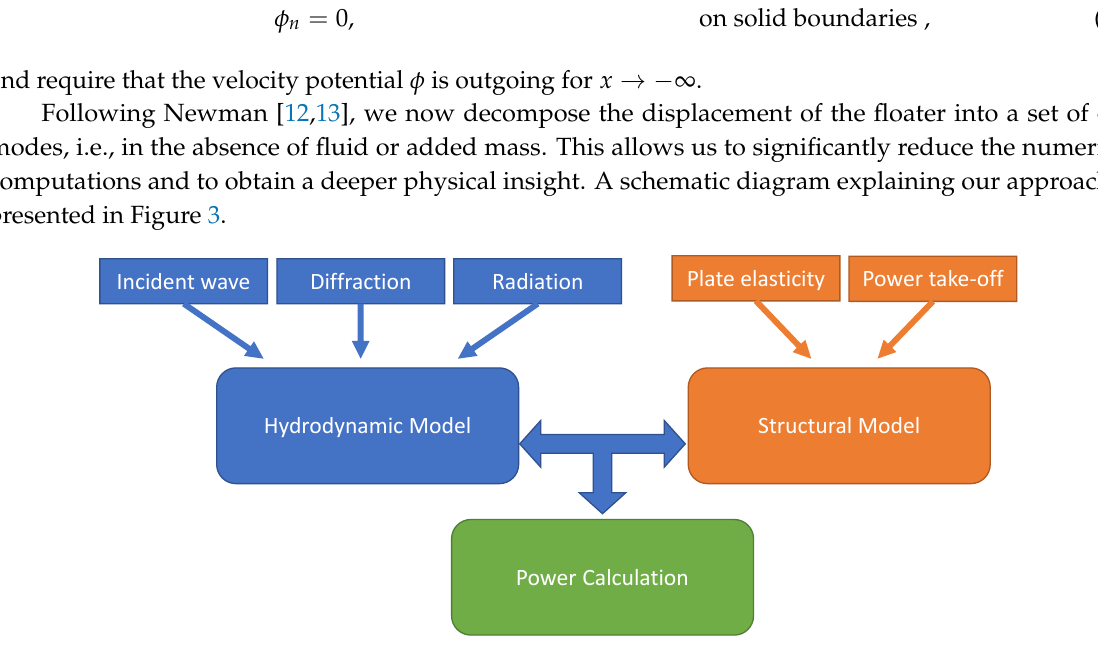
Figure 3. Schematic representation of the mathematical modelling